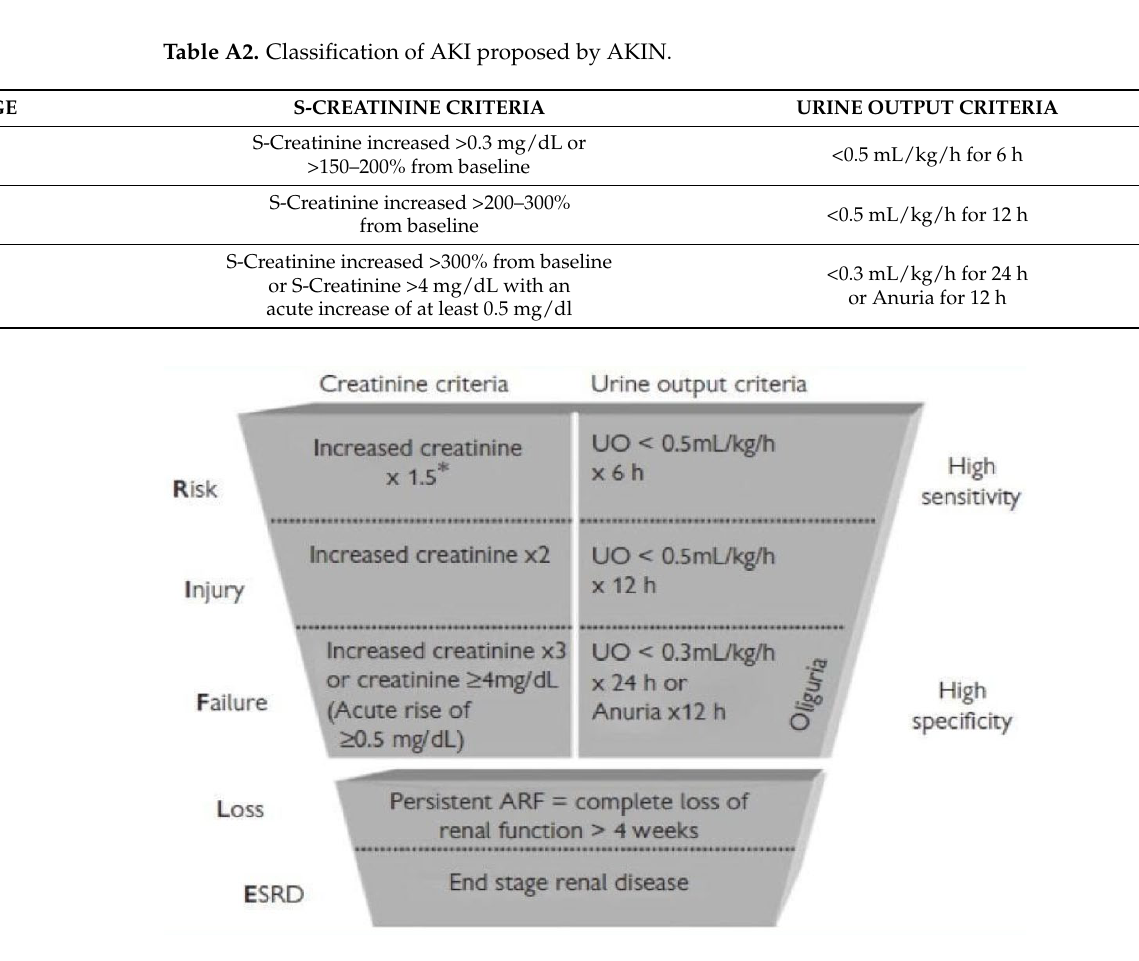
Figure A1. AKIN versus RIFLE CRITERIA. * times